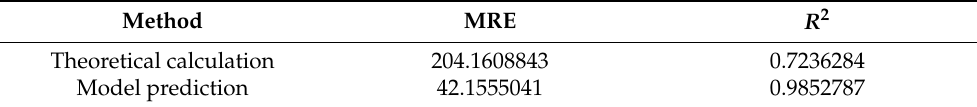
Table 2. Comparison of methods.